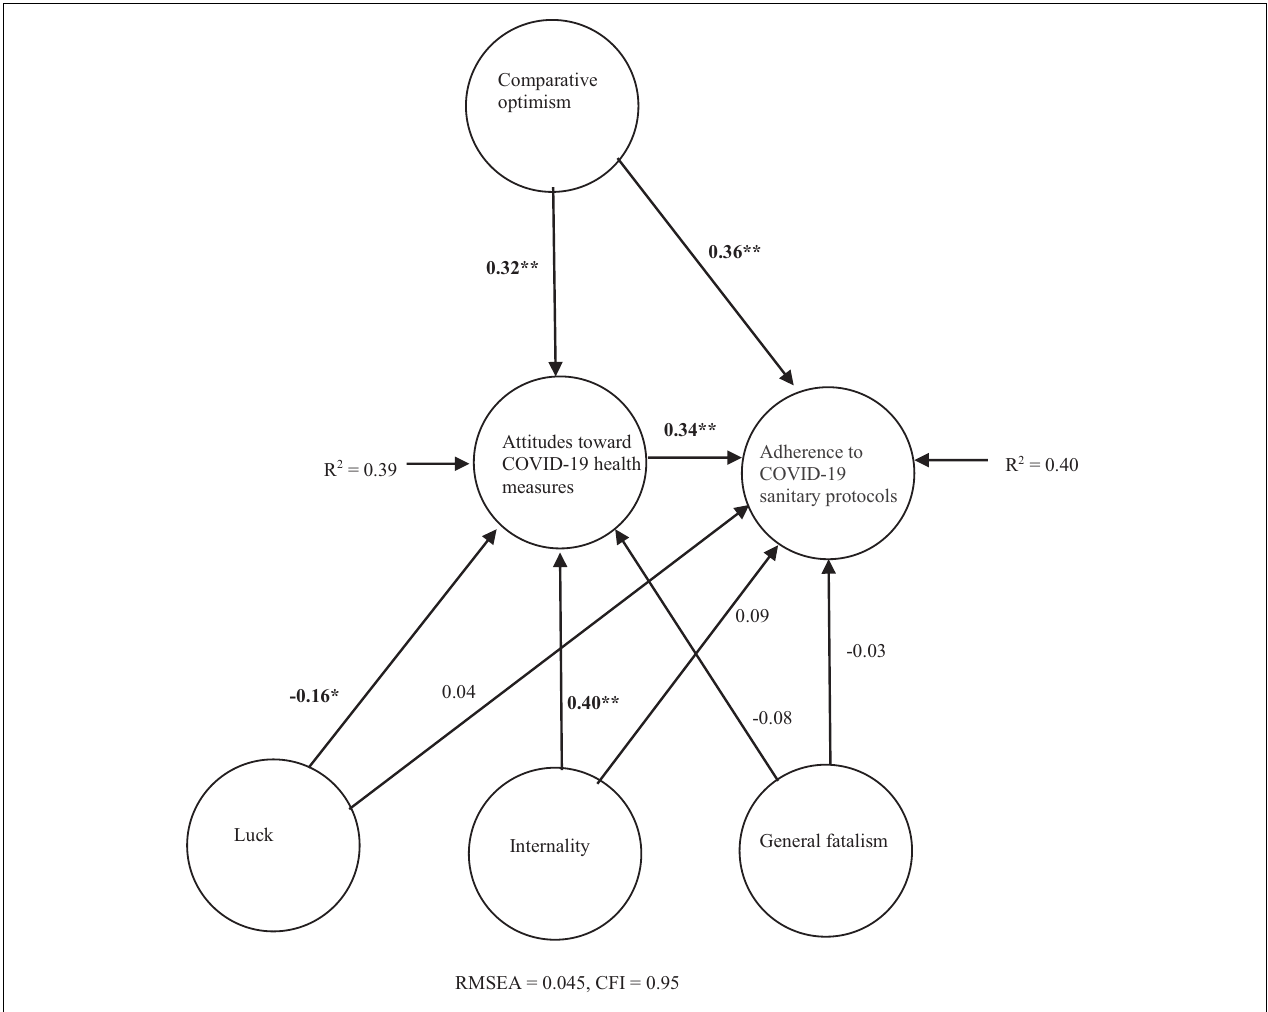
FIGURE 2 | Predictors of adherence to COVID-19 sanitary protocols. Significant standardized path coefficients in bold. * p < 0.05, ** p < 0.001. Model controlled for all possible correlations between the predictors (fatalism factors and comparative optimism). Manifest variables not shown to facilitate interpretation.